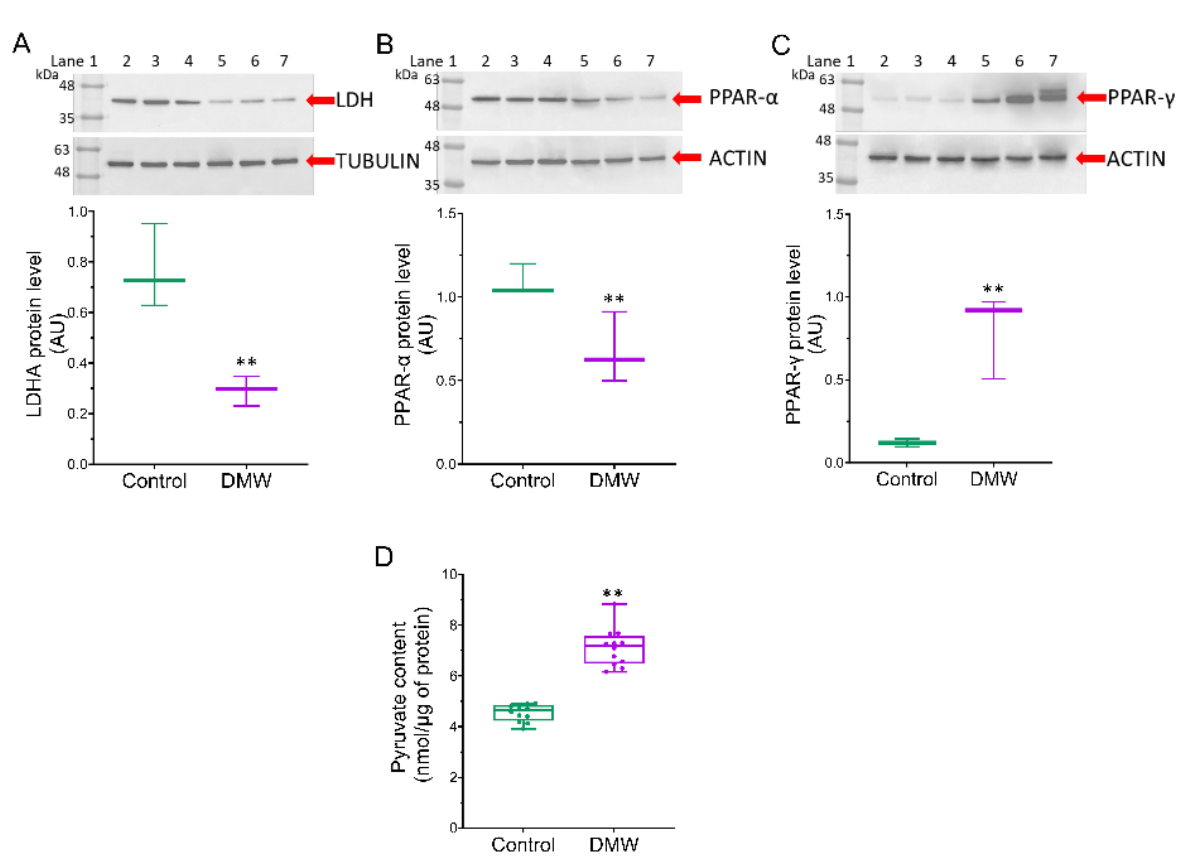
Figure 6. DMW effects on mitochondrial metabolic markers of xenograft model of colorectal cancer. ( A – C ), LDHA, PPAR- α , and PPAR- γ protein levels detected on control and DMW-treated mice. Protein expression was determined after normalisation with α -tubulin or actin as internal control, with ImageJ software and values expressed as arbitrary units (AU). Lane 1 = molecular marker; lanes 2, 3, and 4 = control mice; lanes 5, 6, and 7 = DMW-treated mice. ( D ), Pyruvate content in tissue from control and DMW-treated mice was expressed as nmol/ µ g of protein. ** p < 0.01 vs. control mice.